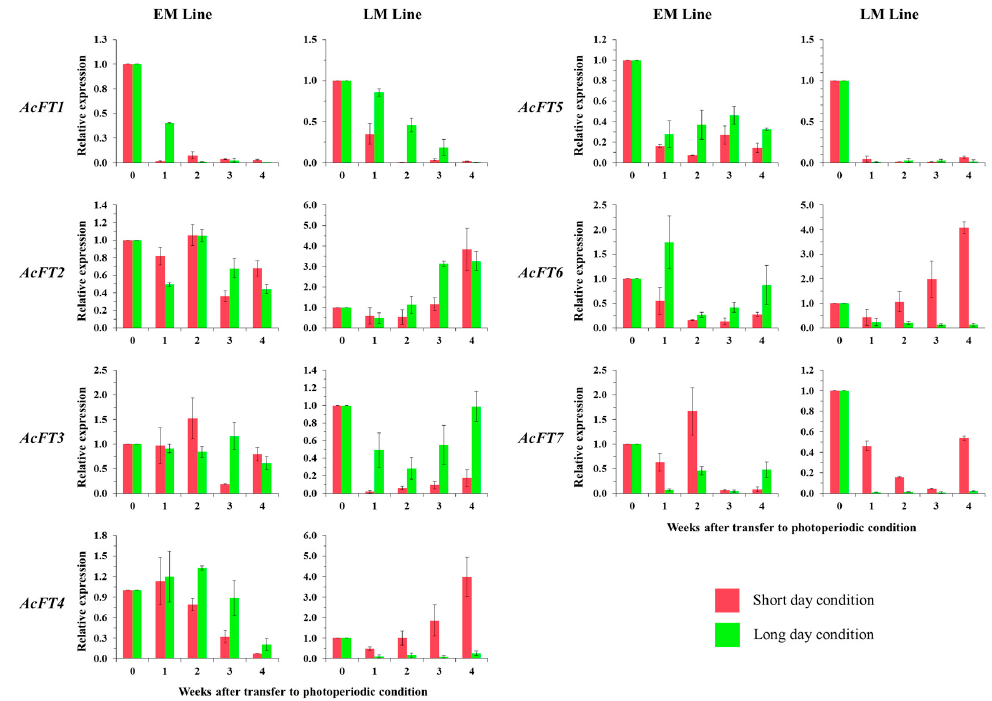
Figure 4. Expression of AcFT genes in EM (early maturation, 36101) and LM line (late maturation, 36122), bulb tissues were studied during Bulb maturation stages under SD (short day) and LD (long day) photoperiodic condition. In the graph, x axis represent samples at various durations of photoperiod treatment (0 to 4 weeks), y axis represent relative expression of FT genes. Data represent an average ± s.e.m of three biological replicates, with transcripts normalized to β -tubulin.